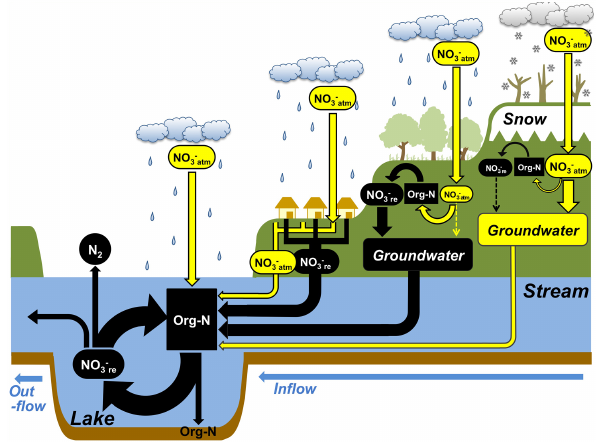
Figure 1. Schematic diagram showing the biological process- ing of atmospheric nitrate (NO − (atm)) and remineralised nitrate 3 (NO − (re)) in the watershed with catchments of various land uses 3 and in the lake water